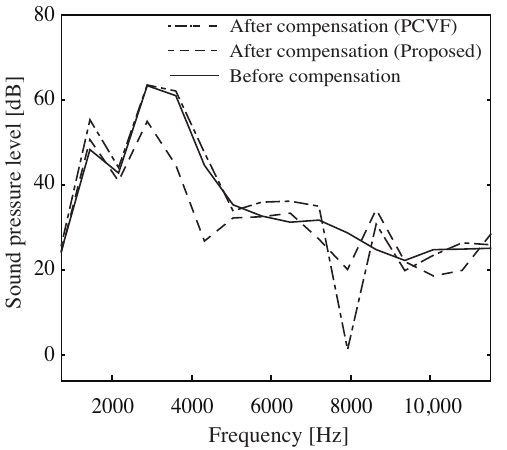
Figure 6. Comparison of compensation of third-order harmonic distortion between proposed method and parallel-cascade truncated Volterra